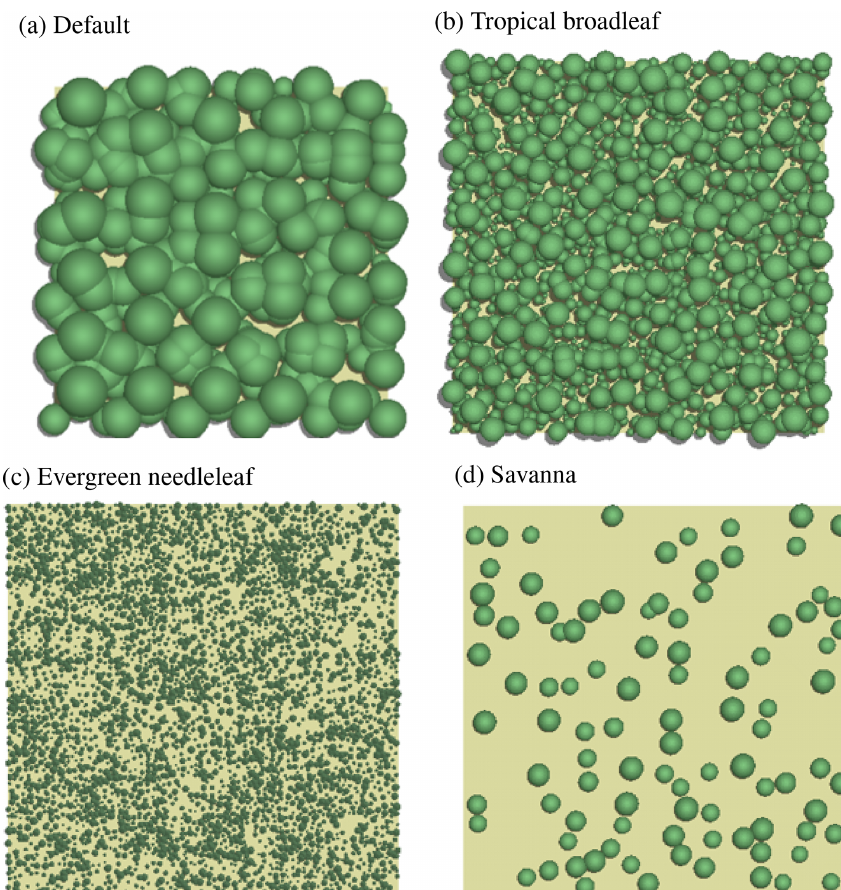
Figure 5. The forest landscape used in the sensitivity analysis. The landscape size is 1ha (100m × 100m). The tree positions and canopy heights are determined by the random numbers. (a) Default forest: crown shape is spheroid, tree density is 359 treesha − 1 , canopy layer height is 5–20m, and crown coverage is 88%. (b) Tropical broadleaf forest: crown shape is spheroid, tree density is 1816 treesha − 1 , canopy layer height is 5–30m, and crown coverage is 88%. (c) Evergreen needle forest: crown shape is cone, tree density is 3592 treesha − 1 , canopy layer height is 5–15m, and crown coverage is 49%. (d) Savanna: crown shape is spheroid, tree density is 96 treesha − 1 , canopy layer height is 5–10m, and crown coverage is